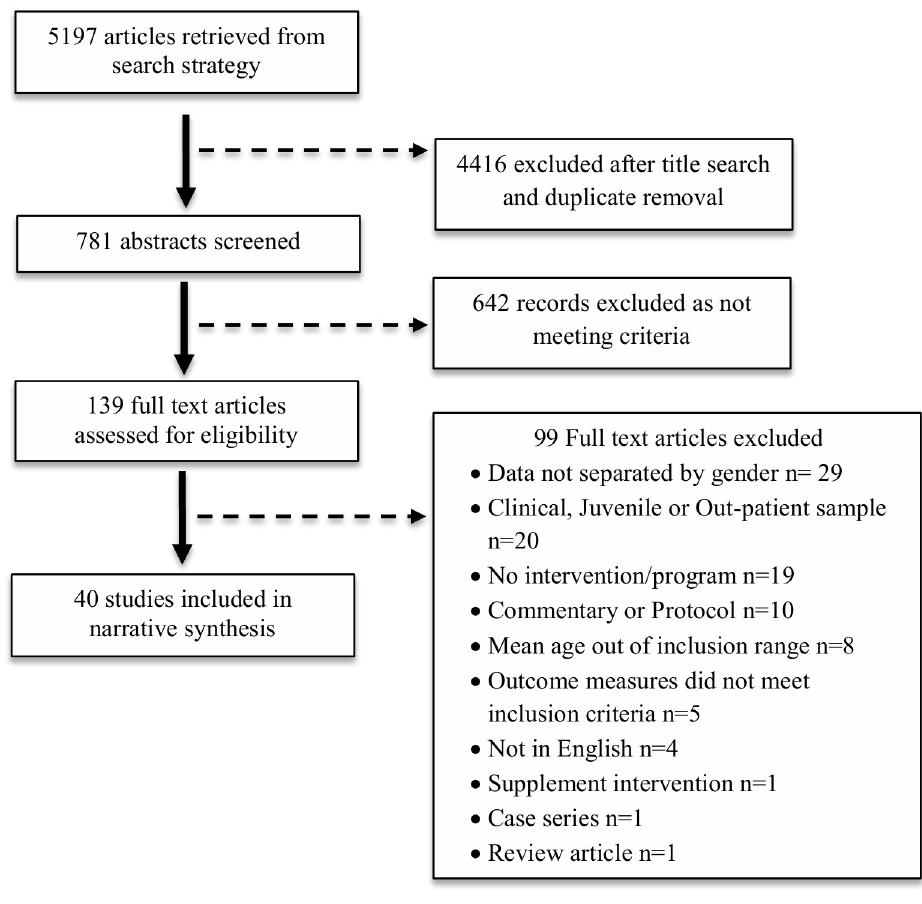
Fig 1. PRISMA flow